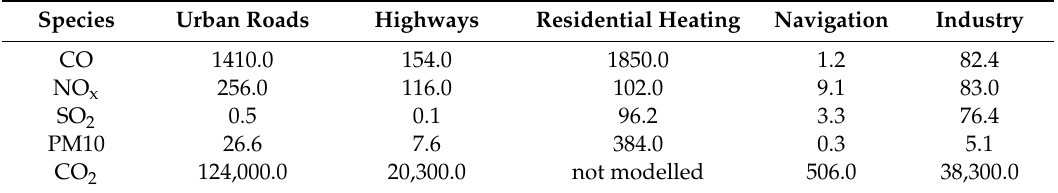
Table 5. Summary of total emissions calculated in the present study for all source categories (tons / week).